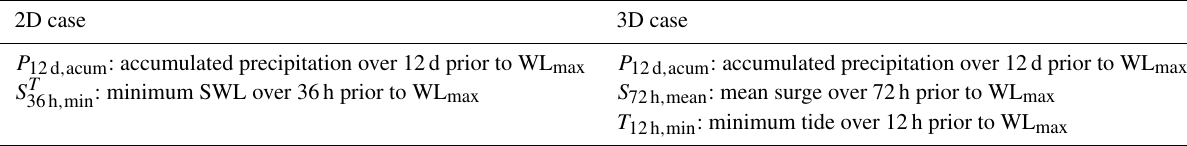
Figure 2. Composite of flooding drivers and associated IWL response for the 2D (a) and 3D (b) cases, which are computed using all 800 annual maxima events. Solid lines represent the median of all values at a given time, whereas the shaded areas depict the values between the 5th and 95th percentiles. Vertical lines indicate the time windows used for the selected predictors (see Table 1). Table 1. Selected predictors for the 2D and 3D